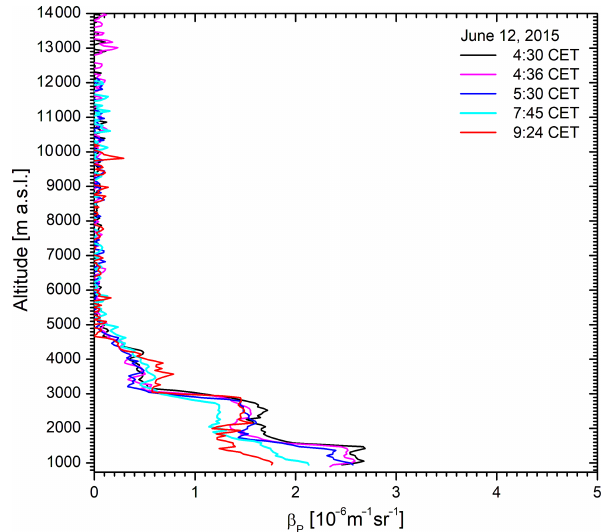
Figure 18. 313nm aerosol backscatter coefficients for 12 June 2015.